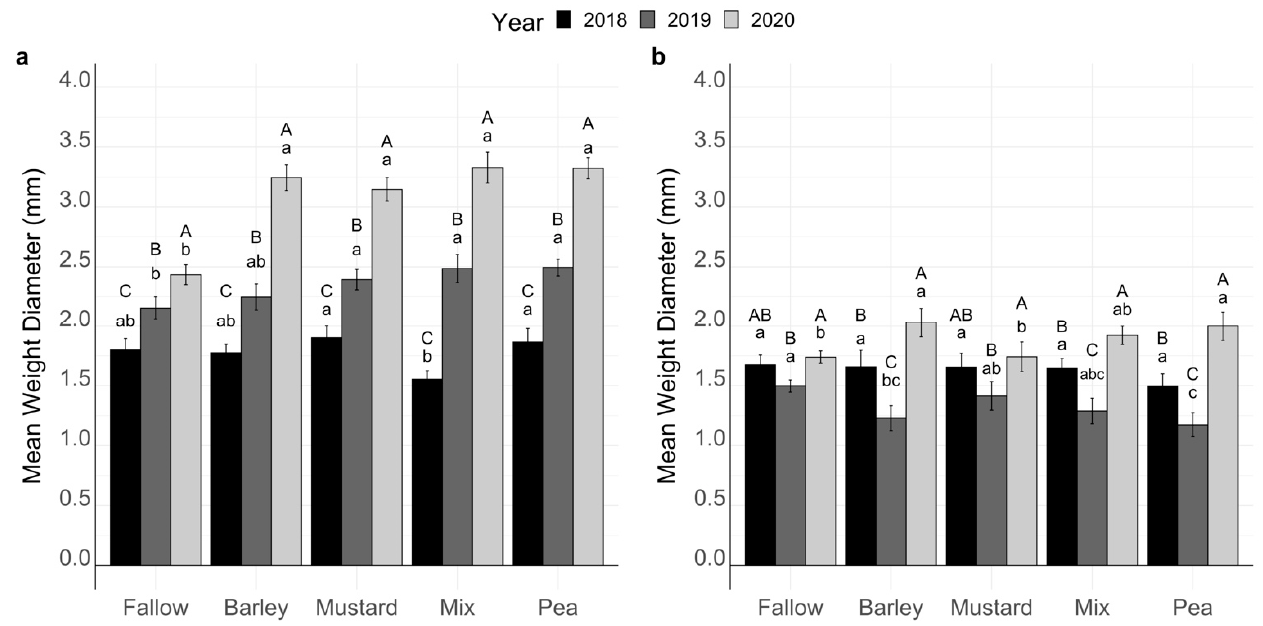
Figure 2. Mean weight diameter (MWD) for cover crop treatments, 2018–2020 at Leyendecker ( a ) and Los Lunas ( b ) farms. Uppercase letters which are different indicate differences within treatments between years, and lowercase letters which are different indicate differences between treatments within a year at p ≤ 0.05. Means have been averaged over irrigation treatments.